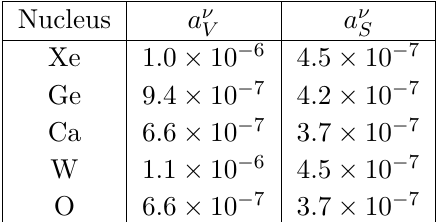
Table 1 . Values of the coe(cid:14)cients a (cid:23) reduction of the CNSN cross session according to eqs. (3.19) and